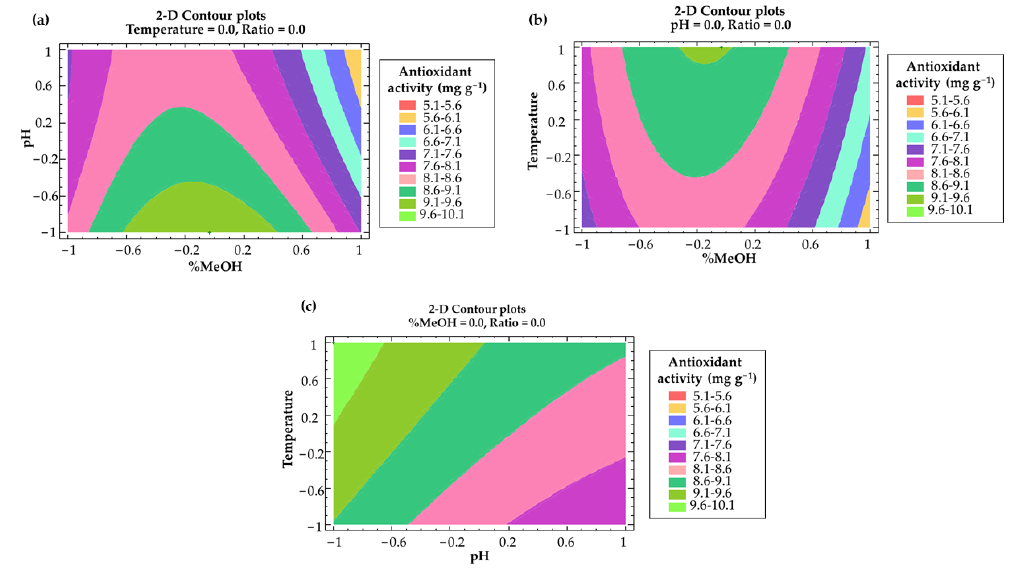
Figure 6. A 2D contour plot of the BBD using RSM to represent the combined effects of ( a ) solvent composition and pH; ( b ) solvent composition and temperature; ( c ) pH and temperature on the response variable antioxidant activity (Y DPPH ).